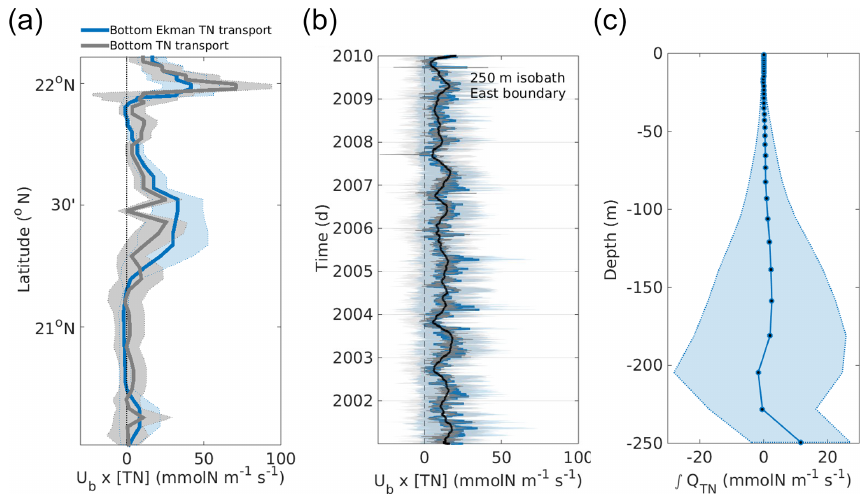
Figure 15. Flux of TN ( Q TN ) computed by the bottom Ekman transport ( U bE , m 2 s − 1 ) for the 9 simulated years (blue) compared with the bottom-most layer TN flux (grey, mmolNm − 1 s − 1 ) over the Ekman bottom layer for (a) temporal averages and (b) spatial averages over the 250m isobath, where the superimposed black line is the bottom Ekman transport filtered with a 90d moving average. (c) Vertically integrated TN flux along the eastern 250m isobath, averaged over latitude and over the 9 simulated years in mmolNm − 1 s − 1 . Shaded areas denote the standard deviation of the averages.